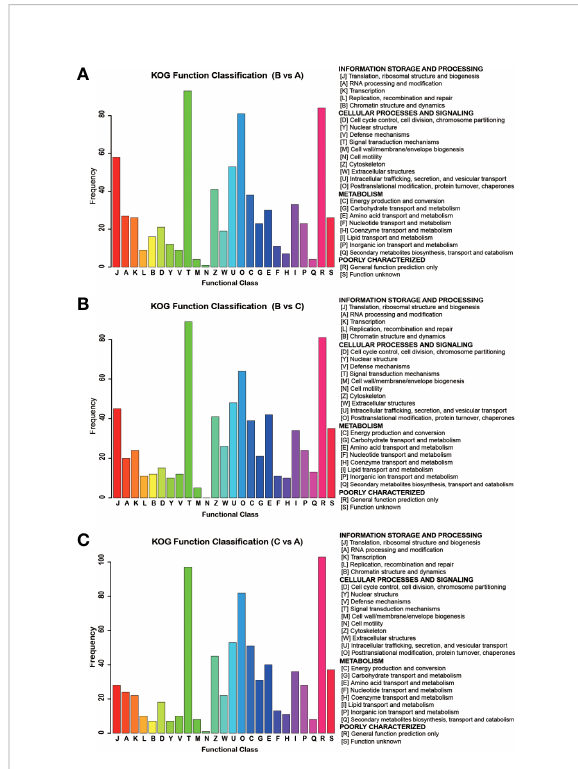
FIGURE 7 COG analysis of DEPs detected between different groups of S. japonica . DEPs detected in group B vs group A (A) , group B vs group C (B) and group C vs group A (C) , were categorized according to the information storage, cellular, signalling, and metabolism process.